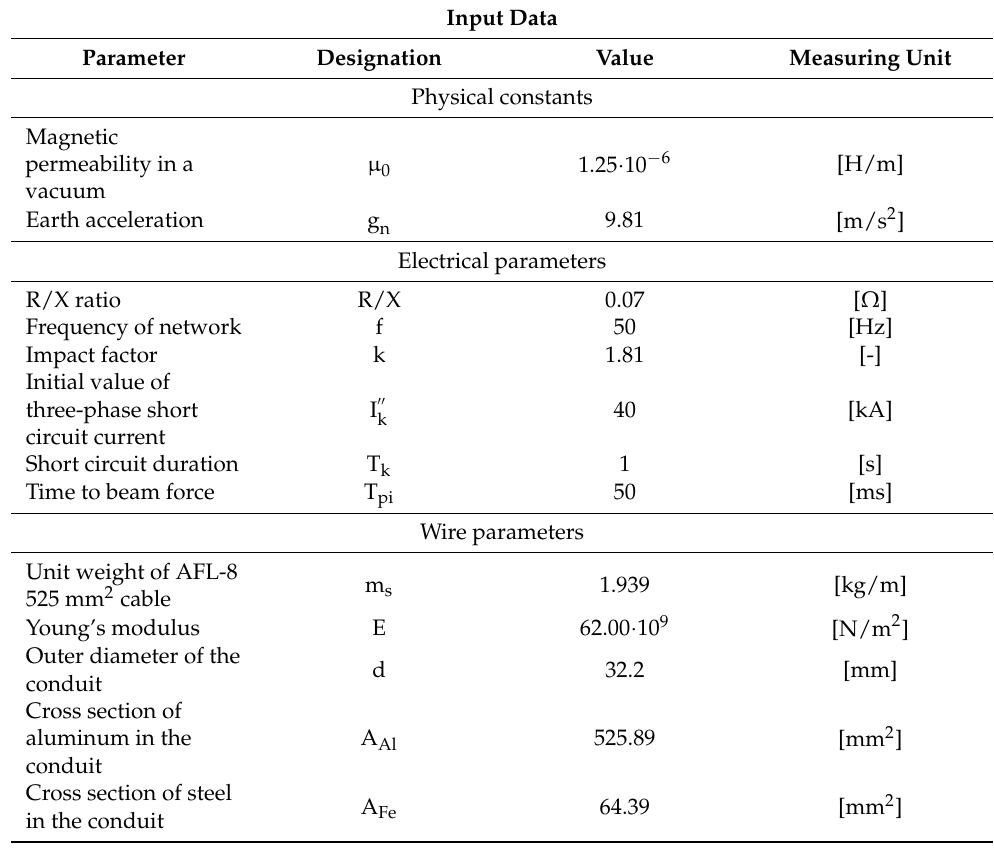
Table 1. Calculation of dynamic effects of short-circuit current. Connection made with flexible conductors; input data